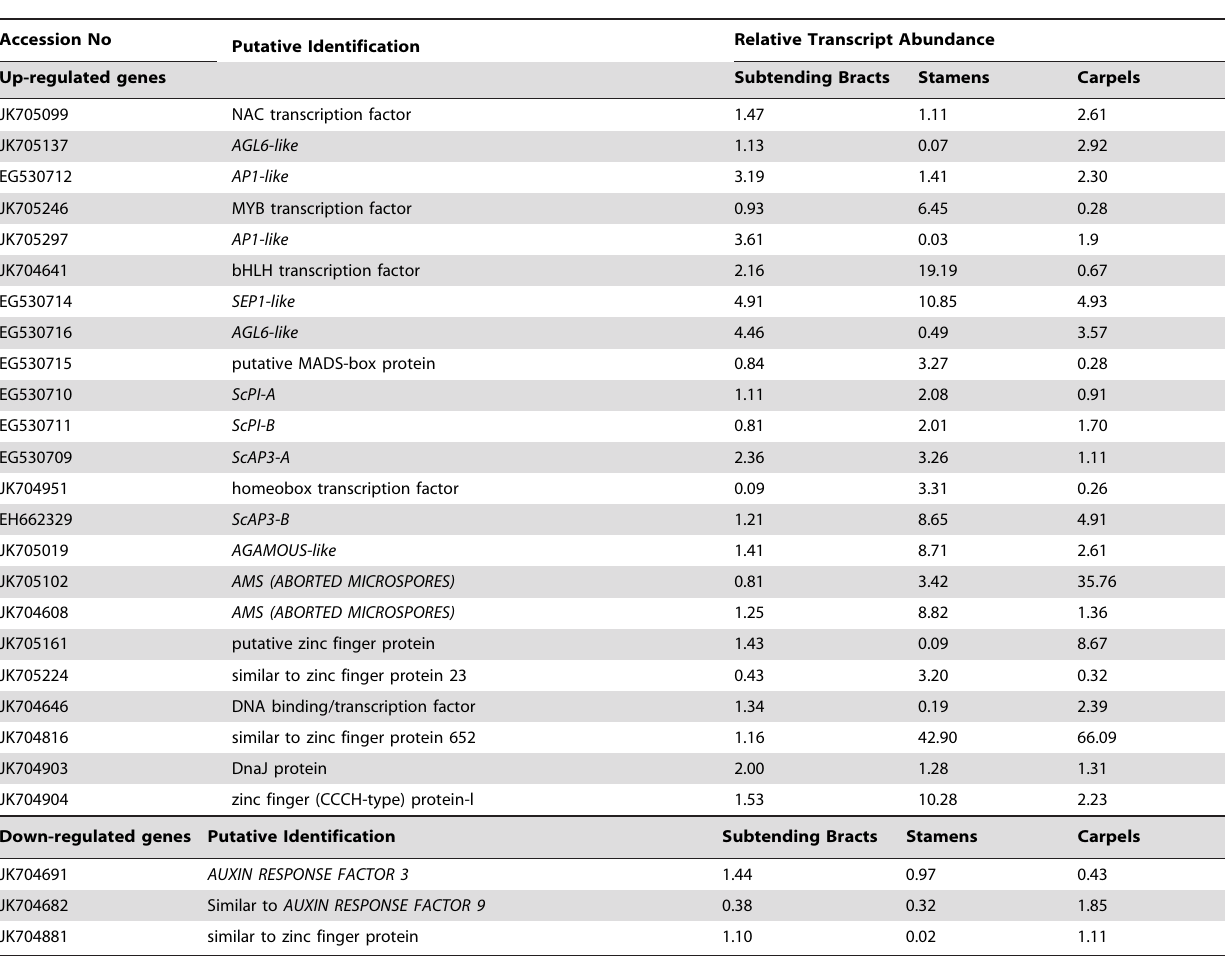
Table 2. Subset of transcription factors determined to be up- or down-regulated in inflorescence tissues, relative to their transcript abundance levels in developing seedling